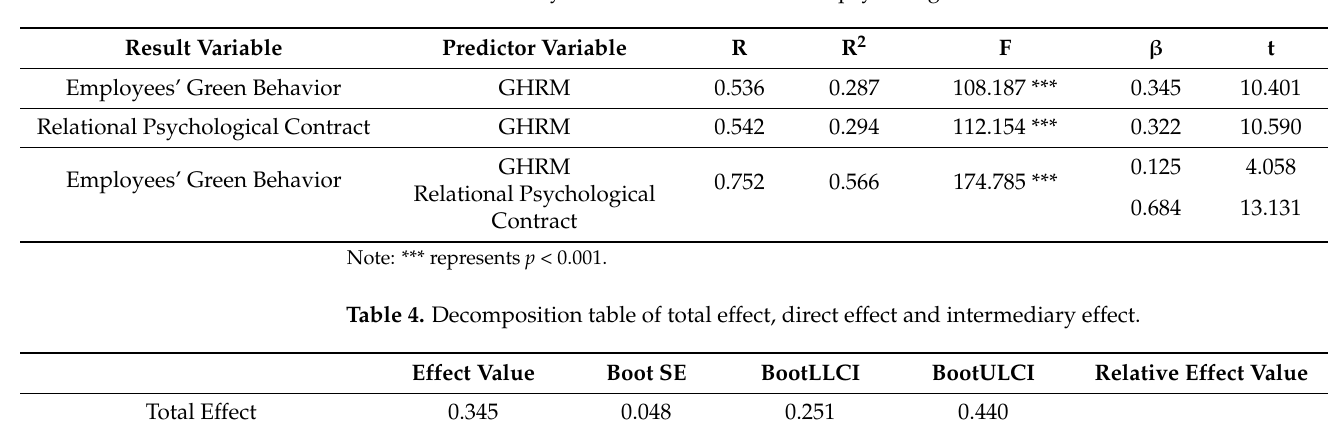
Table 3. Intermediary model test of the relational psychological contract.